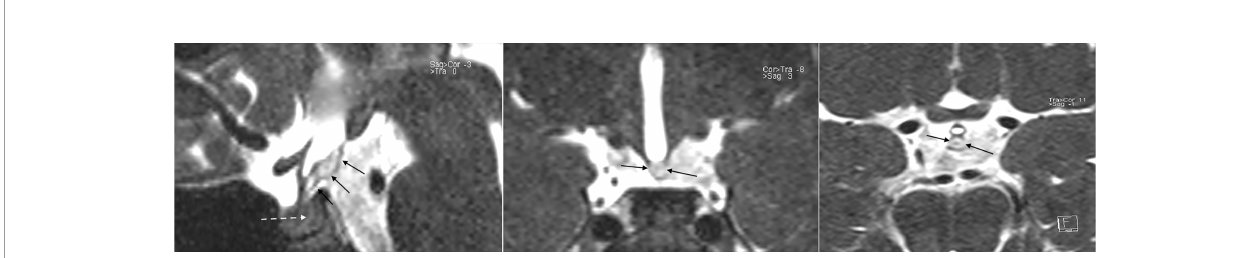
FIGURE 3 | 3D T2w SPACE sequences (sagittal, coronal and axial from left to right) show a high signal posterior to the tuber cinereum and poor contrast of the other tissues (continuous arrows); meaning the presence of a tissue in the suprasellar cistern, posterior to the tuber cinereum, different from neurohypophysis which remain hypointense as expected (dotted arrow). Fat has high signal on this sequence, suggesting being a lipoma of the tuber cinereum. The careful consideration of these sequences at the fi rst MRI scan, furtherly to routine sequences, could have driven promptly to the 3D Fat Suppression T1w VIBE sequences for con fi